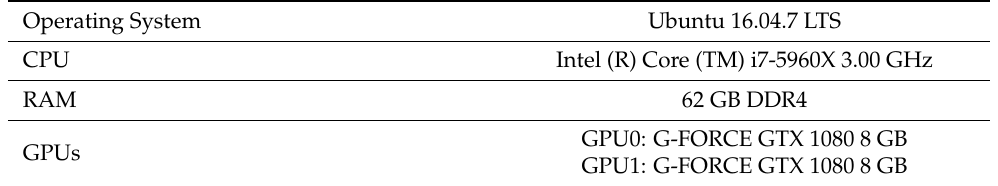
Table 3. Hardware